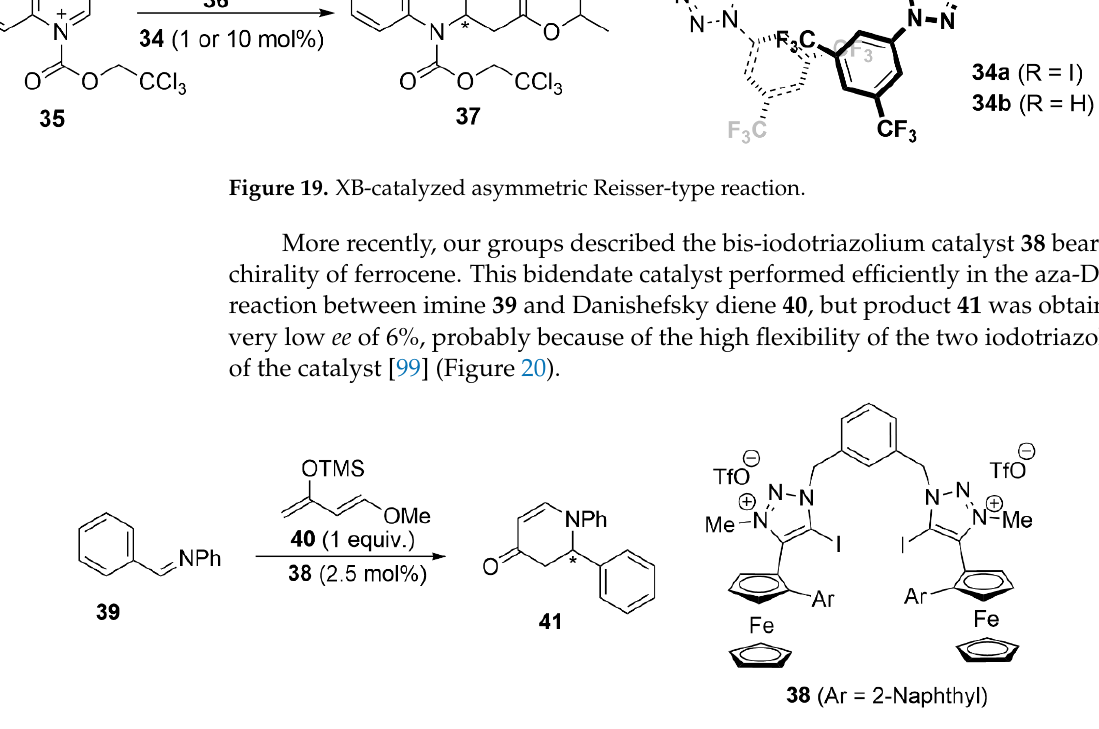
Figure 20. XB-catalyzed asymmetric aza-Diels–Alder reaction.